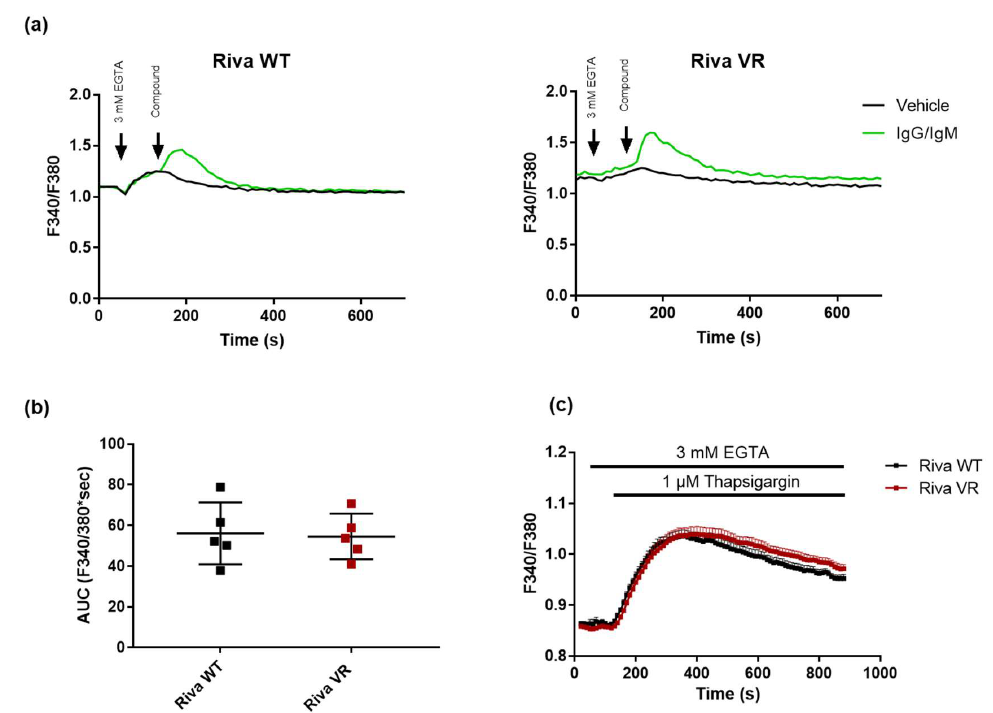
Figure 3. Cytosolic IgG/IgM Ca 2+ responses and ER Ca 2+ content do not differ between Riva WT and Riva VR. ( a ) Typical cytosolic Ca 2+ traces in Fura-2-AM-loaded Riva WT and VR. Sixty seconds after the chelation of extracellular Ca 2+ with EGTA (3 mM), the cells were stimulated with vehicle or 12 µg/mL IgG/IgM to provoke a cytosolic Ca 2+ signal. ( b ) Analysis of the area under the curve (AUC) of the IgG/IgM-triggered peak. Data are presented as average ± SEM (N = 5). ( c ) Cytosolic Ca 2+ traces in Fura-2-AM-loaded Riva WT (black) and VR (red). Sixty seconds after the chelation of extracellular Ca 2+ with EGTA (3 mM), the cells were treated with thapsigargin (1 µM) to deplete ER Ca 2+ stores. Data are presented as average ± SEM (N = 6).